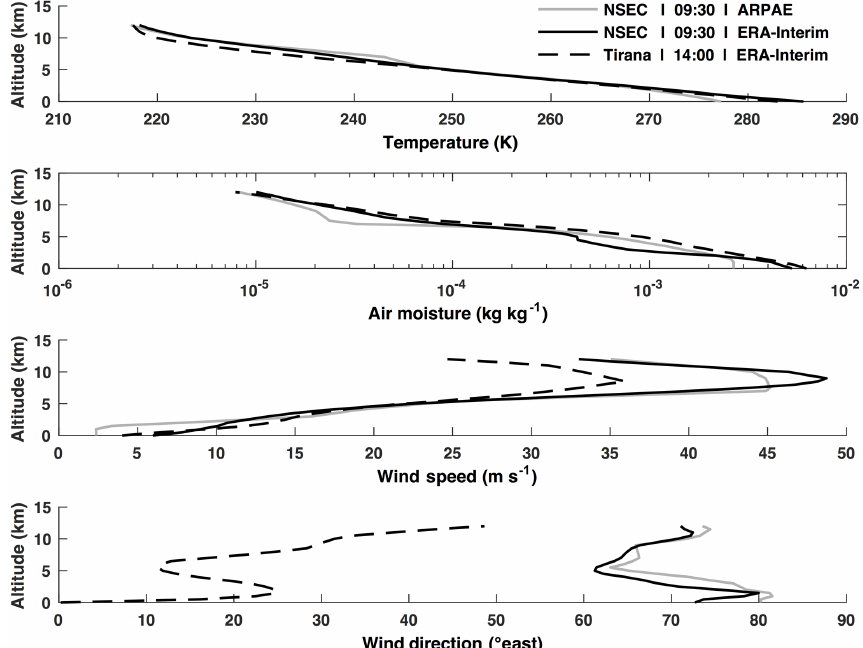
Figure 6. The main meteorological profiles over the NSEC from ARPAE (INGV-OE) and ERA-Interim (ECMWF), and over Tirana for